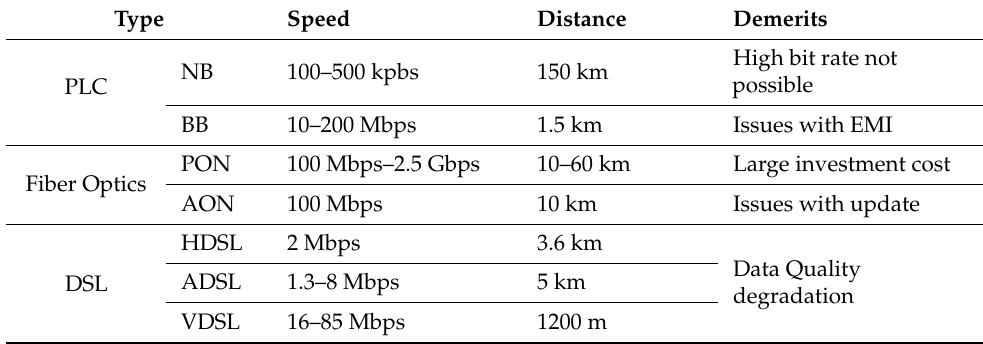
Table 1. Comparison between different wired